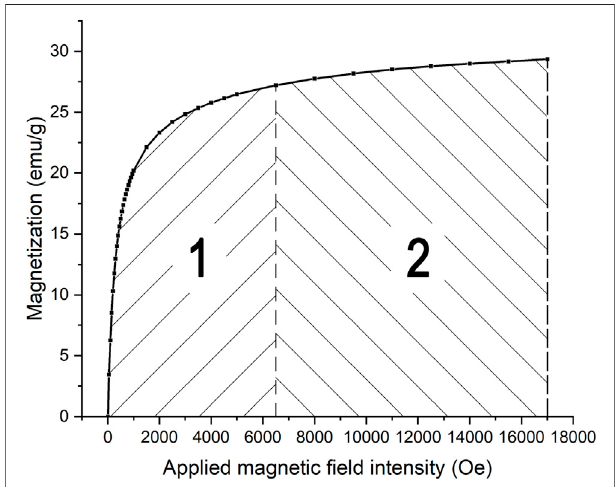
FIGURE4| M – Hcurveofthetypicalmagnetic fl uid(1-unsaturatedzone, 2-saturated zone).